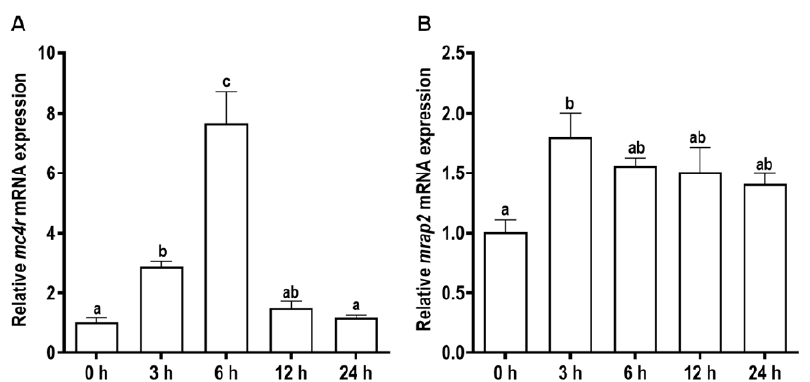
Figure 5. Effects of short-term (24 h) fasting on the expressions of cerebral mc4r ( A ) and mrap2 ( B ) in snakehead. Data were represented as mean ± SEM ( n = 6). Significant differences ( p < 0.05) between groups were detected using a one-way ANOVA. Groups that differ significantly were indicated by different letters above bars.